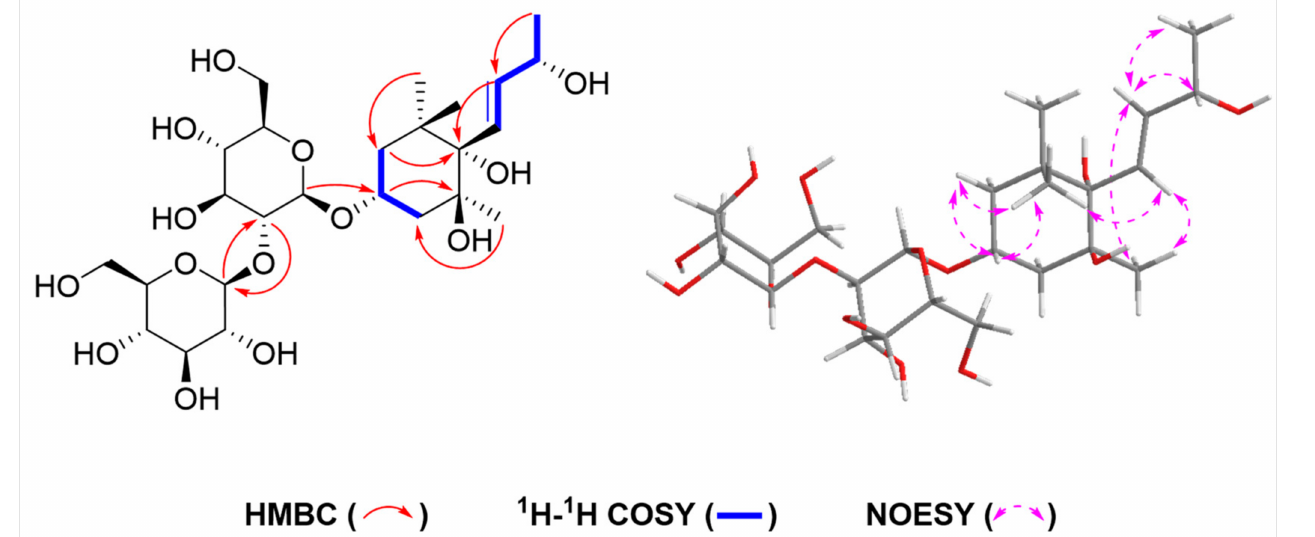
Figure 2. Selected HMBC, 1 H- 1 H COSY and NOSY correlations of 1